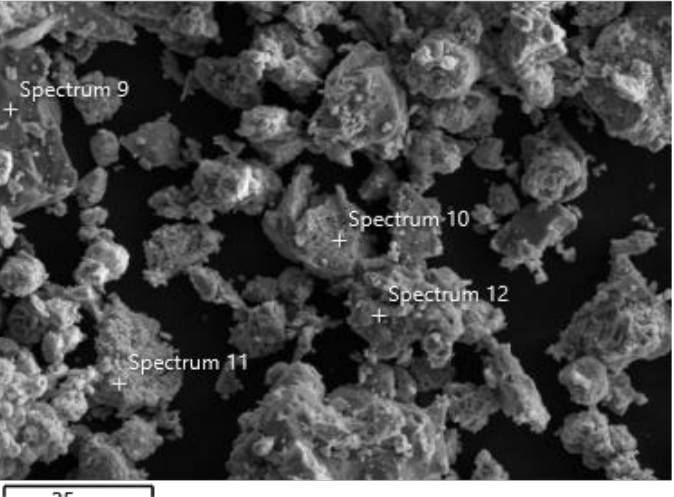
Figure 6. SEM analysis of the oxidized particles at 1000 °C with places of the EDX Analysis (Spec- trum 9, Spectrum 10, Spectrum 11 and Spectrum 12).